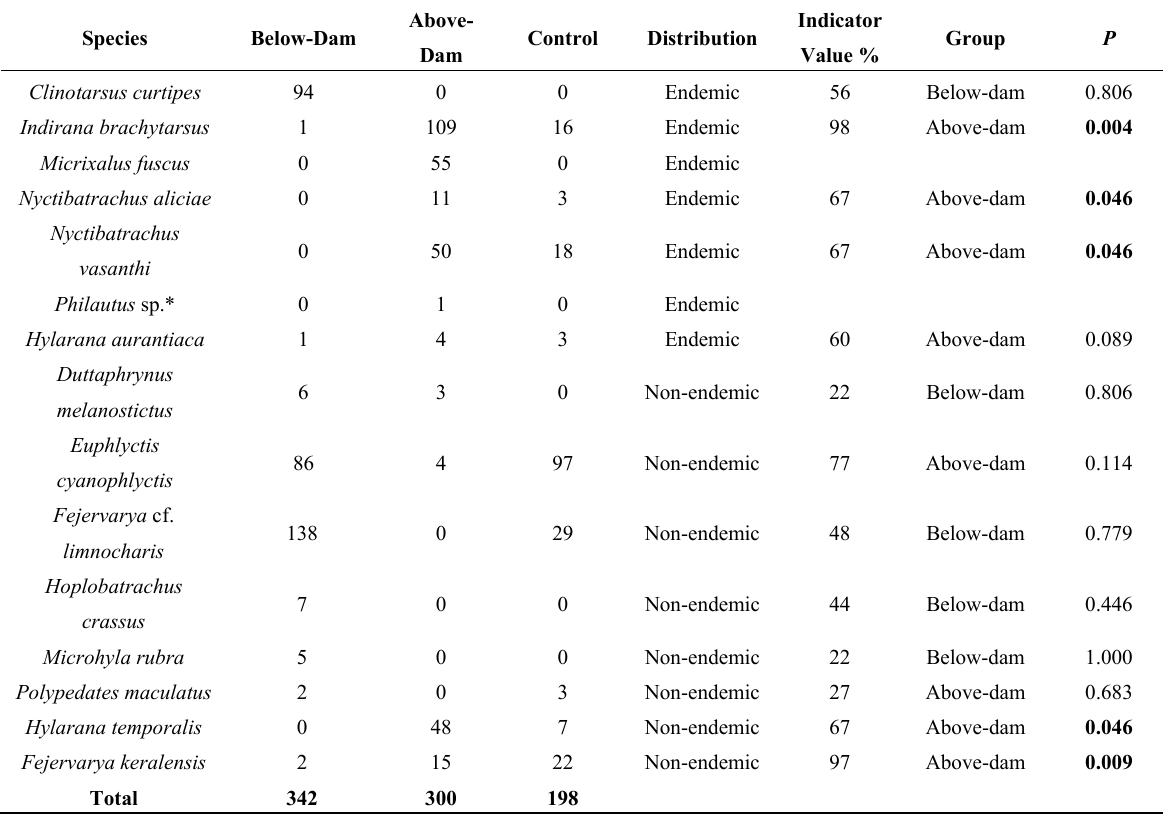
Table 2. Number of individuals of the fifteen species of frogs seen in each of the two treatments and control along with information on distribution of each of the species. The last three columns summarize the information of the Indicator Value analysis for each species. Indicator Value % is the maximum indicator value observed for the species in the two groups (below- and above-dam) and ‘p’ is the proportion of randomized trials with indicator value equal to or exceeding the observed indicator